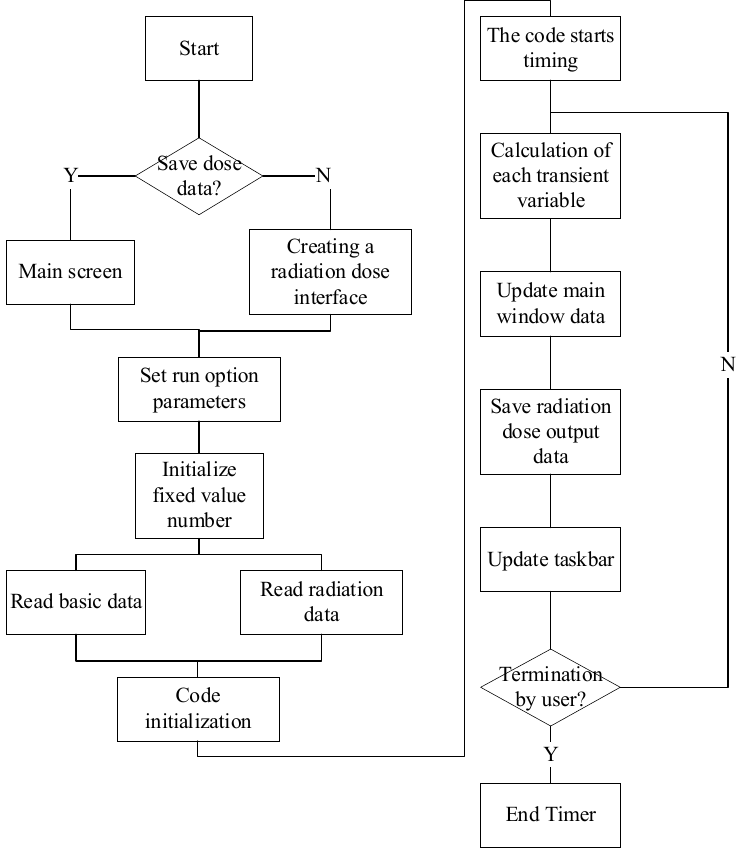
Figure 2. PCTRAN general flow block diagram.